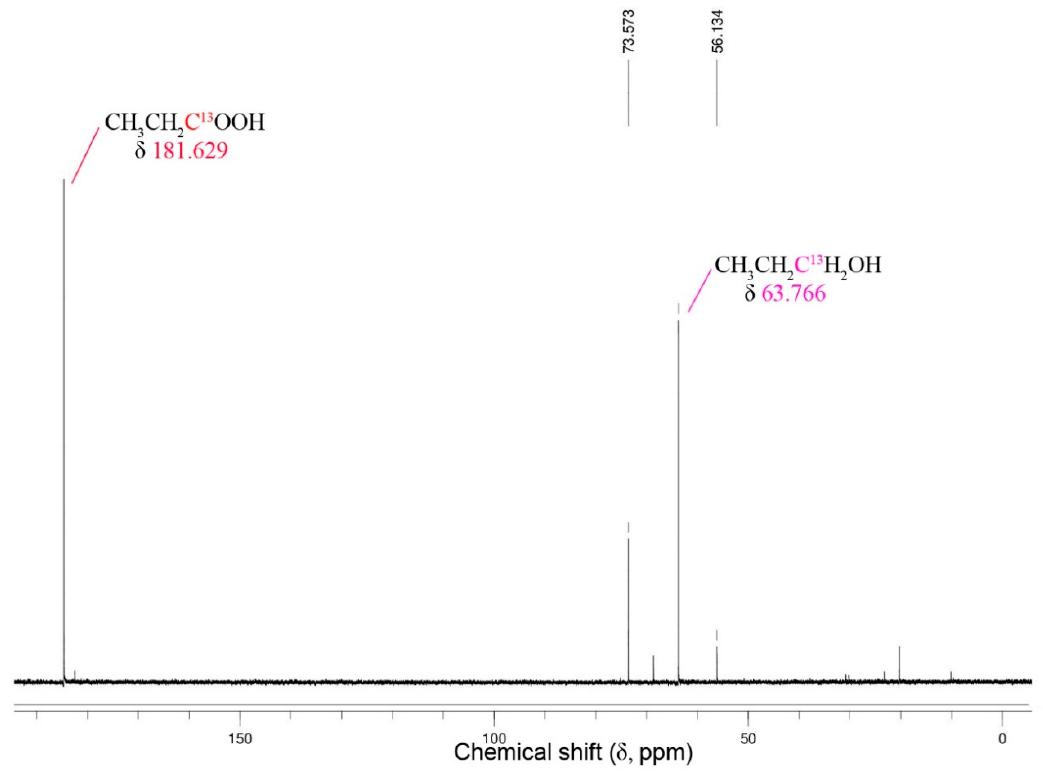
Figure 7. 13 C NMR spectra for the reduction of 13 C1-labeled propionate by Thermoanaerobacter strain AK152 after 5 days of fermentation with glucose (20 mM) at 65 °C, pH